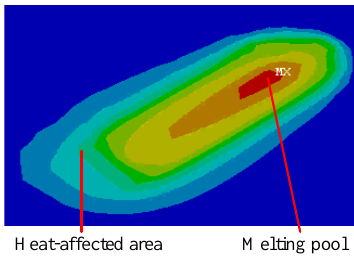
Figure 2. Melting pool and heat-affected area.